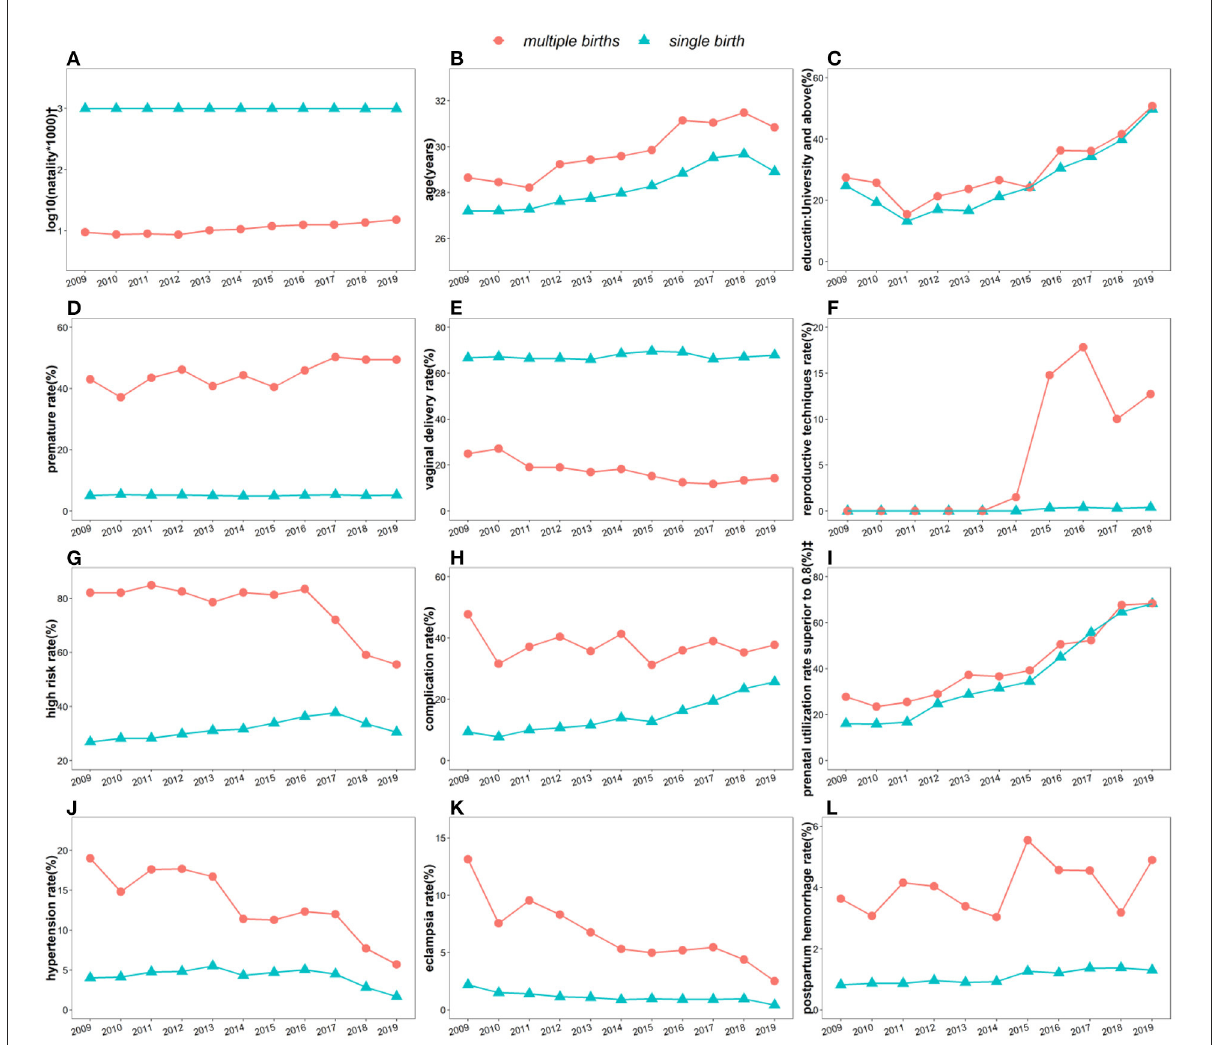
FIGURE1 Secular trends of maternal socioeconomic and biomedical characteristics among 520,860 participants sub-categorized by singletons and multiple births in Baoan, Shenzhen, 2009–2019. * (A) Natality, (B) maternal age, (C) education level, (D) premature birth rate ( < 37 week), (E) vaginal delivery rate, (F) pregnancy rate by assisted reproductive technology, (G) high risk factors during pregnancy, (H) maternal complications rate, (I) pre-natal care utilization rate > 80% during pregnancy, (J) antenatal hypertension (K) eclampsia rate, (L) post-partum hemorrhage rate. † One puerpera giving birth to twins or triplets only counts as one multiple pregnancy. ‡ Pre-natal care utilization rate is defined as the ratio between the actual number of visits and the recommended